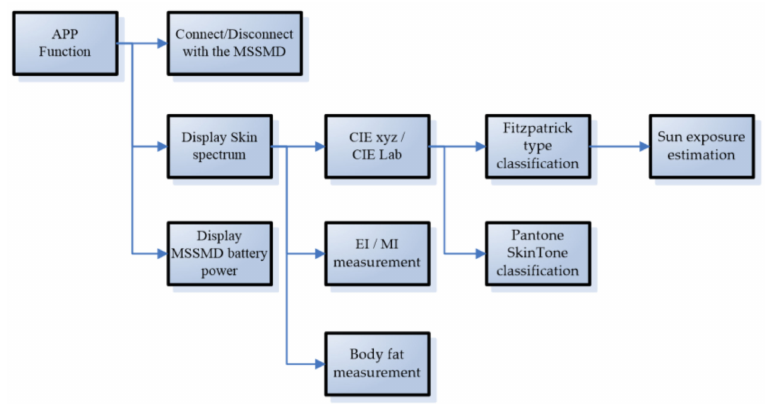
Figure 7. Mobile application